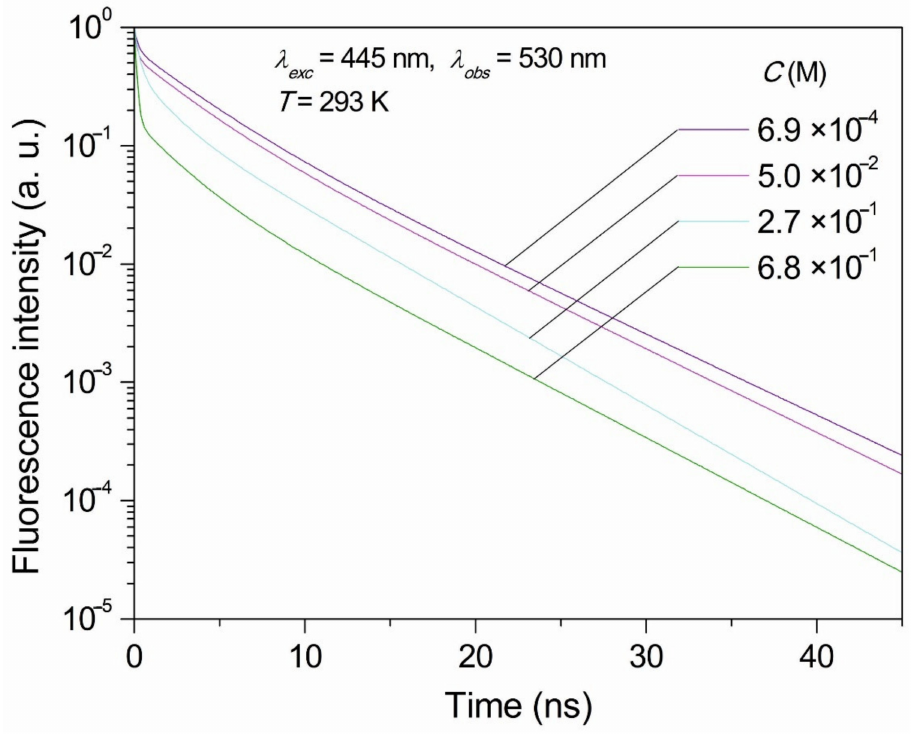
Figure 4. Pure fluorescence decays recovered from the experimental decays shown in Figure 3 and the parameters in Table